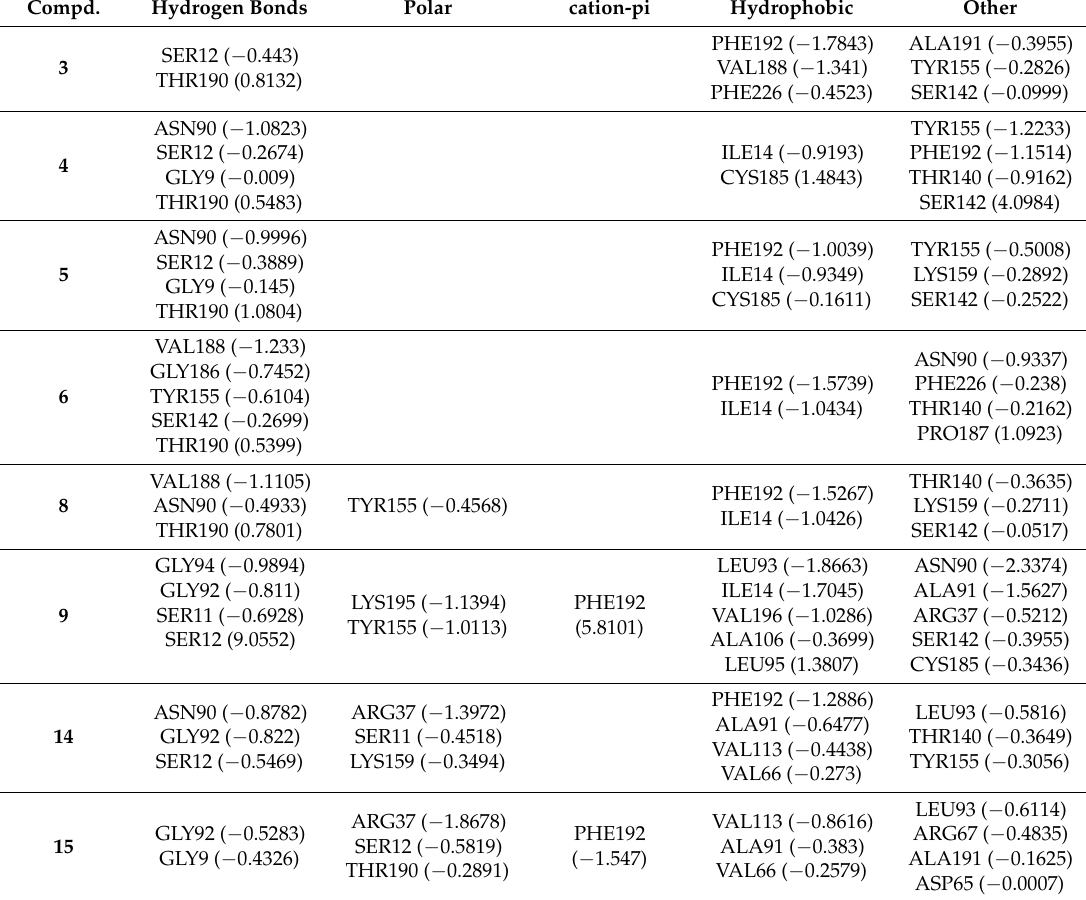
Table 5. Decomposed energy of some synthesized compounds with breast cancer receptor (3hb5).